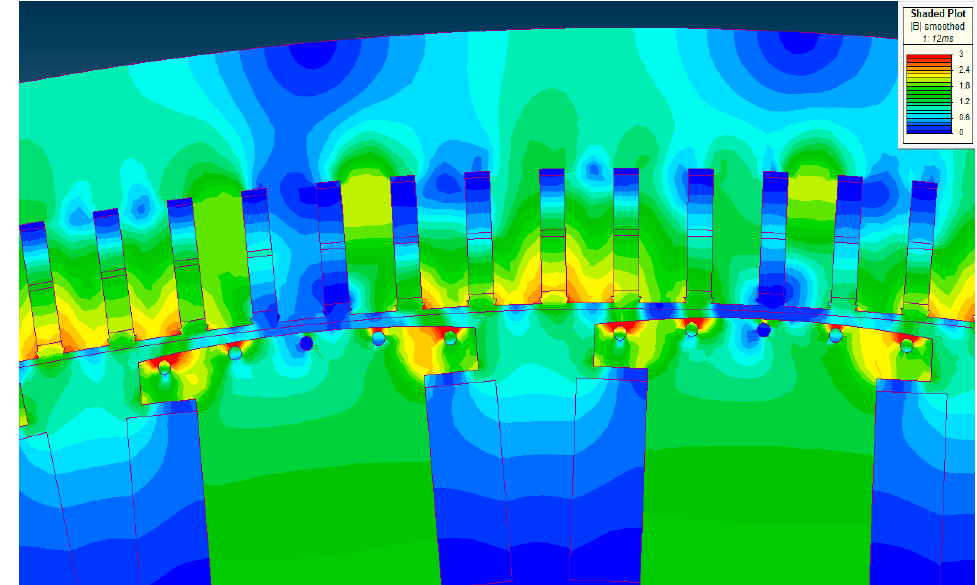
Figure 13. Detail of magnetic field just above the slot half a period after short-circuit.